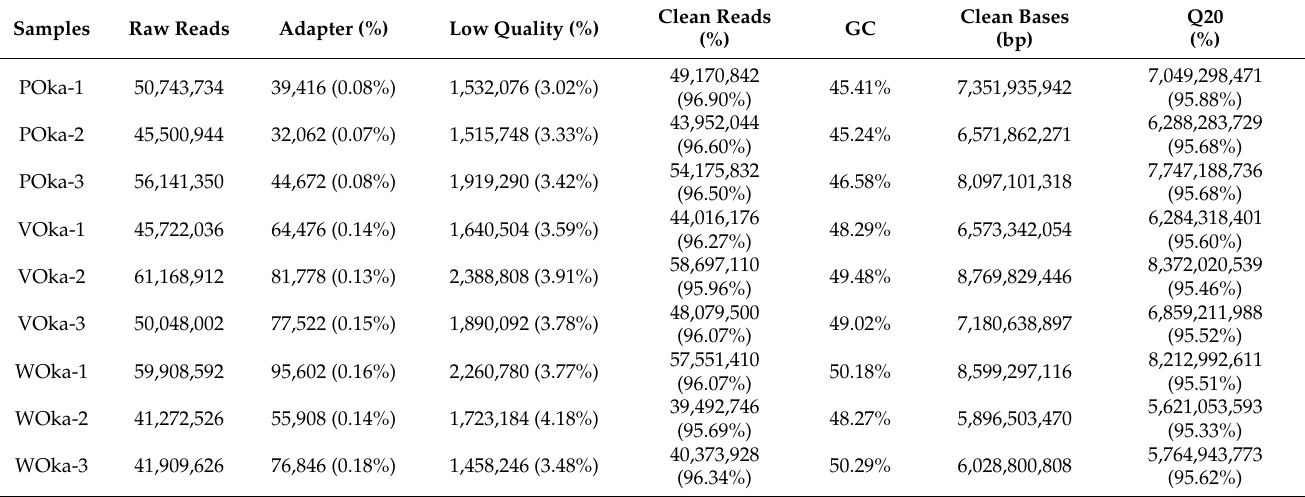
Table 1. Summary of the transcriptome